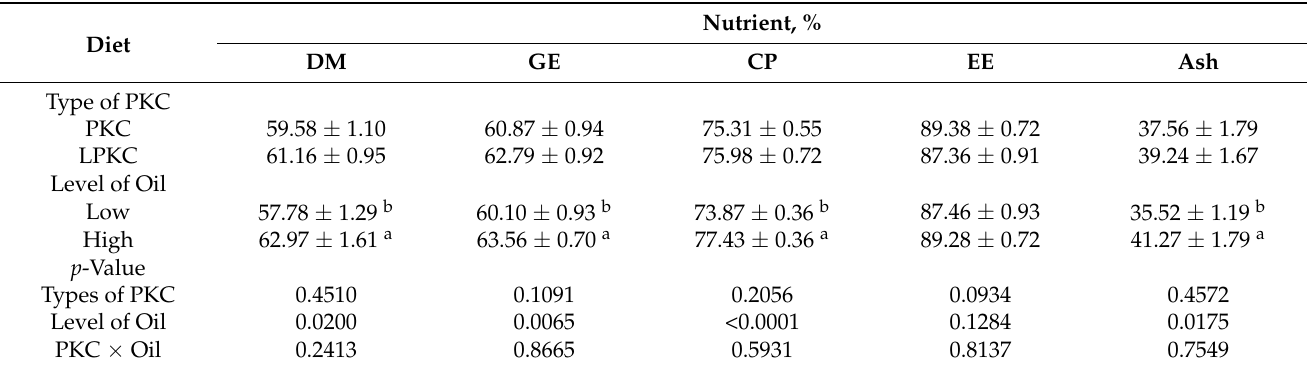
Table 4. Apparent ileal digestibility (%) of nutrients of broilers fed LPKC and PKC-based diets at different levels of oil (Mean ± SE).